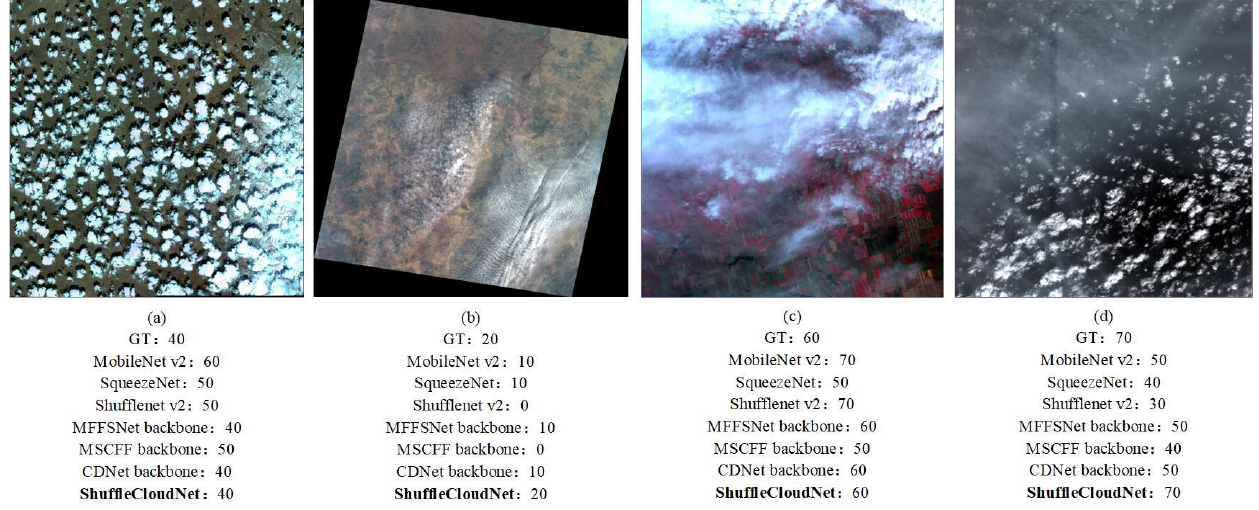
Figure 8. Test example diagram of CTI_RSCloud dataset. ( a ) is an example of cloud amount calculation result of remote sensing image of speckled cloud. ( b ) is an example of cloud amount calculation results of thin cloud remote sensing image. ( c ) is an example of cloud amount calculation result of remote sensing image of thin cloud and thick cloud mixture. ( d ) is an example of cloud amount calculation results of remote sensing images of thin clouds and speckled clouds.